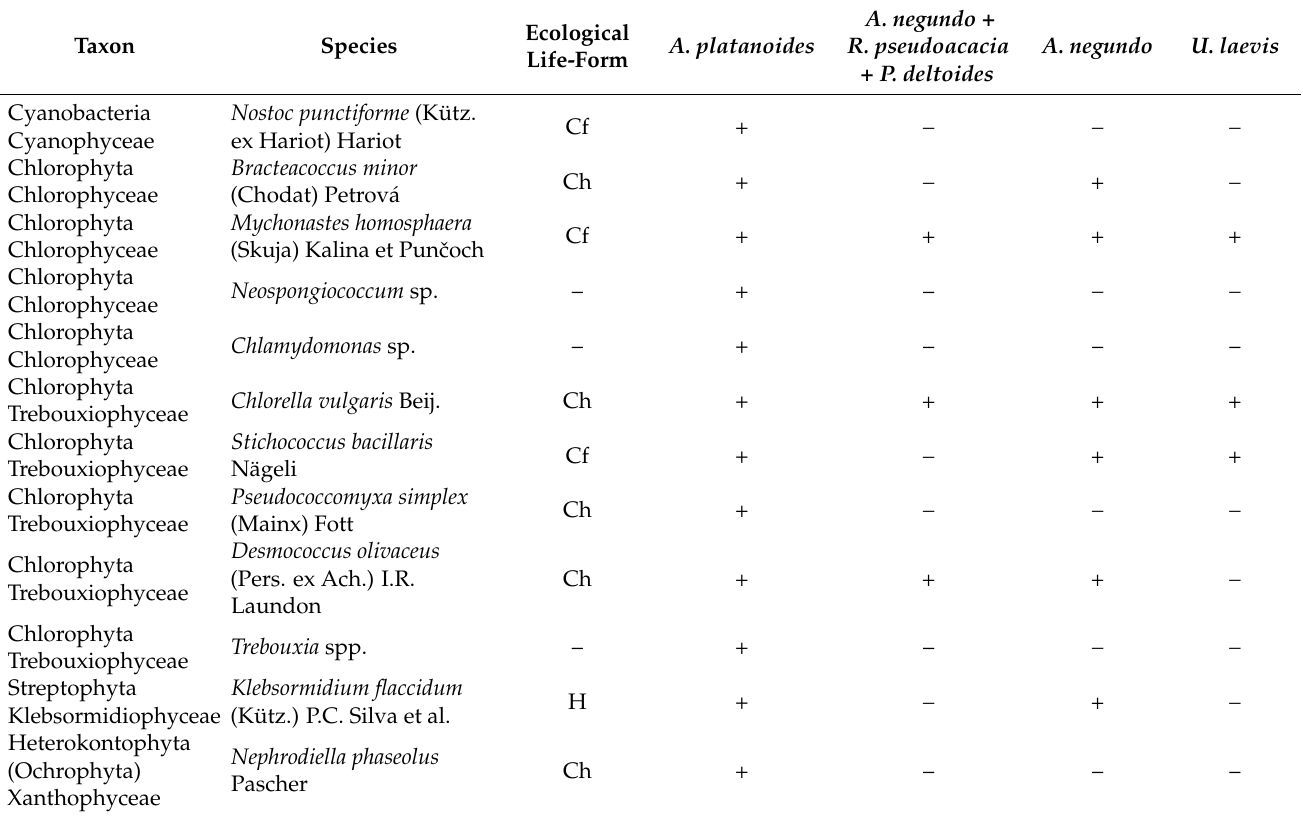
Table 1. Taxonomic composition of algae and their ecological lifeforms from the litter extracts from the Y. Haharin park of Dnipro city ( n =